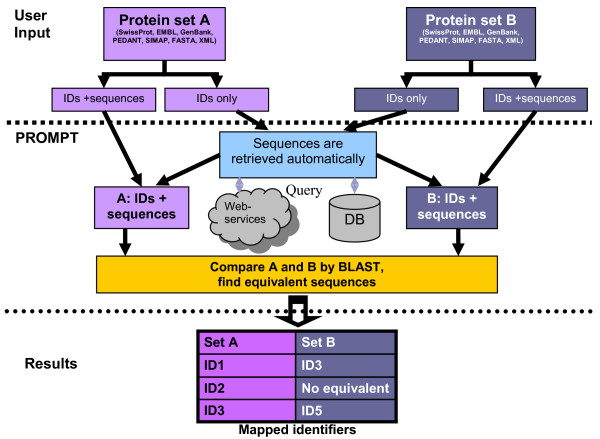
Data input and mapping workflow.